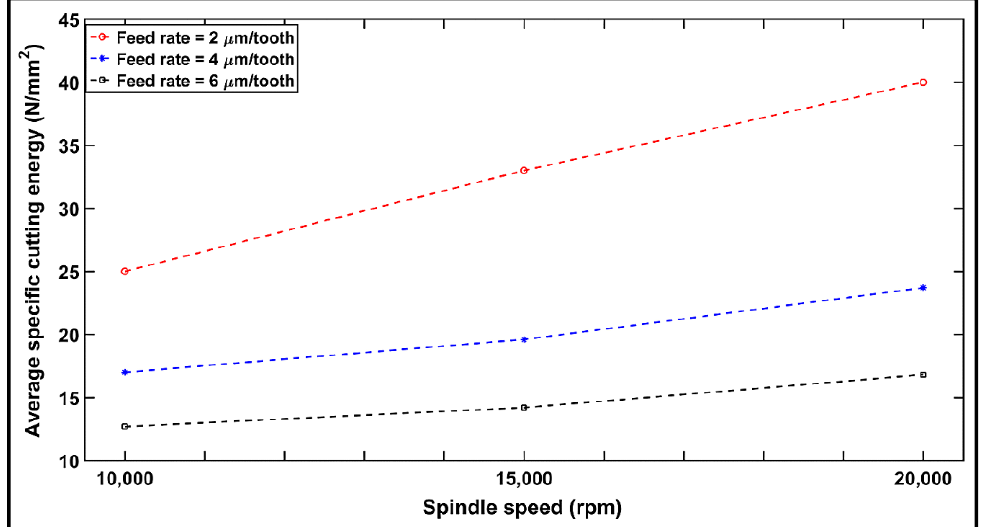
Figure 7. Variation of average specific cutting energy (Equation (4)) as a function of spindle speeds and feed rates.